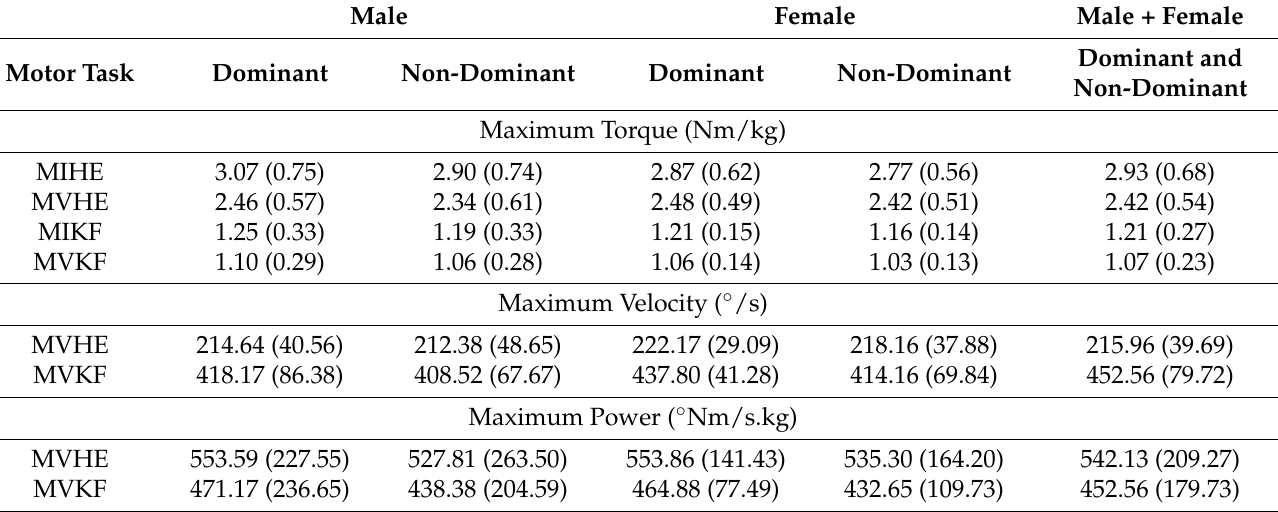
Table 2. Normalized torque, velocity, and power of the hamstring